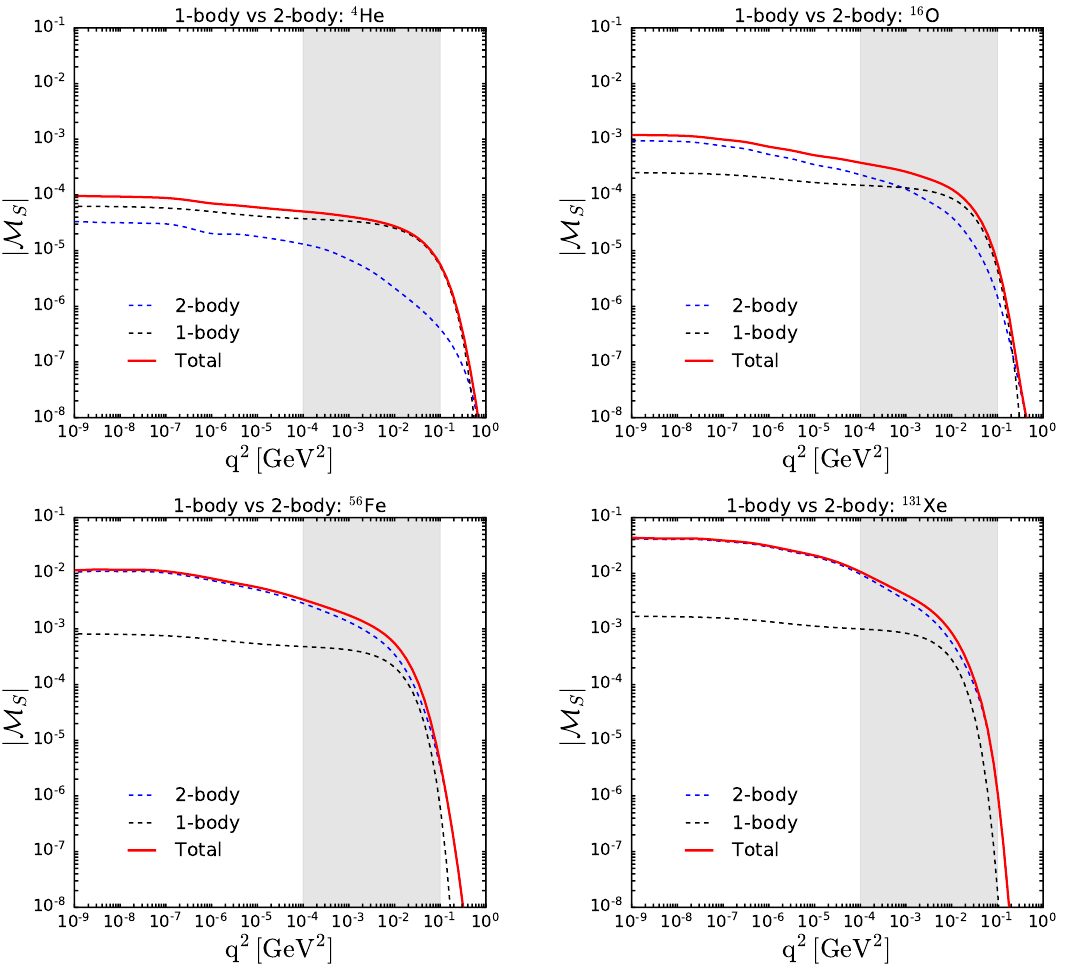
Figure 4. Contributions to the DM-nucleus scalar amplitude, as a function of the squared of the exchanged momentum q 2 ’ − t : one-body (black curves), M 1b The total amplitude is also depicted (red curves). We show results for four different nuclei: helium (left upper panel), oxygen (right upper panel), iron (left lower panel) and xenon (right lower panel). The gray shaded area indicates the range of momentum transfer relevant for scattering processes of local galactic DM off standard